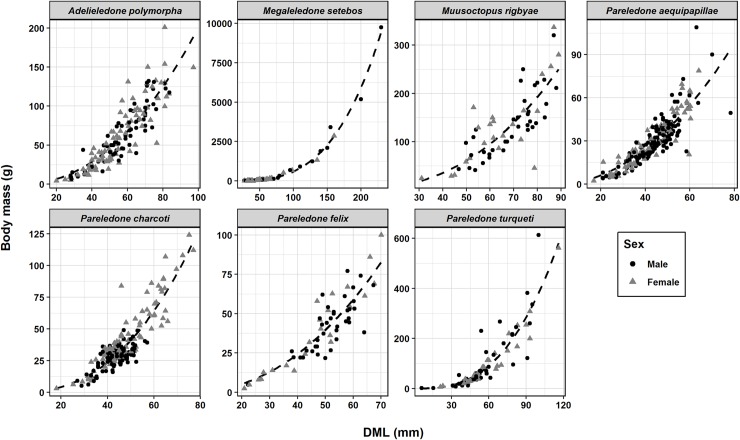
Length-weight relationship of the seven most numerous octopod species. Scale of axes differs between species due to size differences.